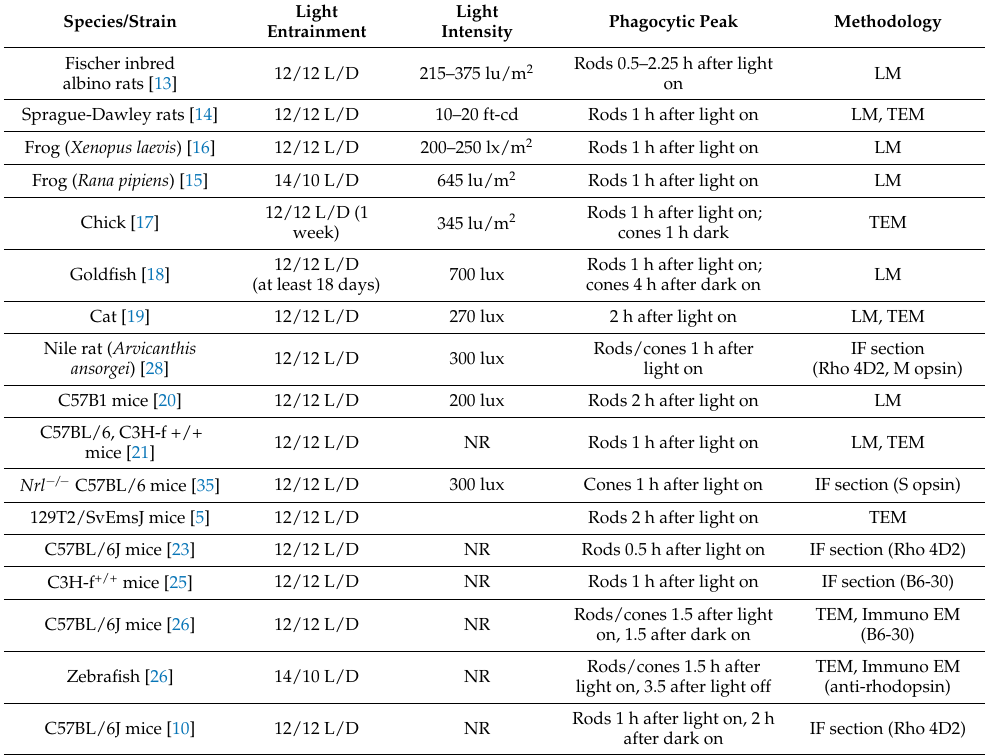
Table 1. Summary of phagocytosis studies in different species and mouse